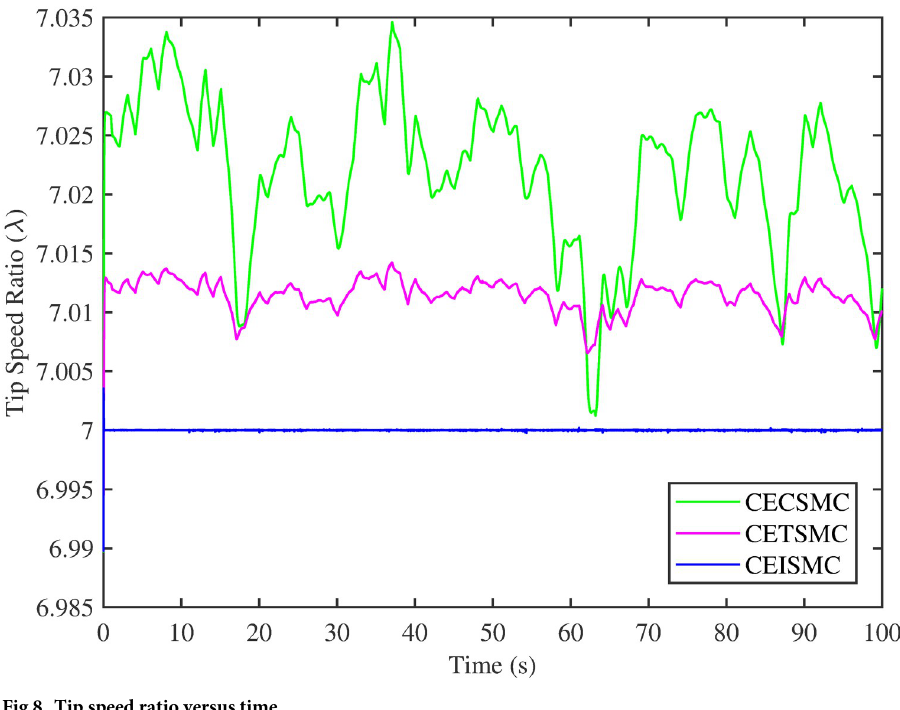
Fig 8. Tip speed ratio versus time.